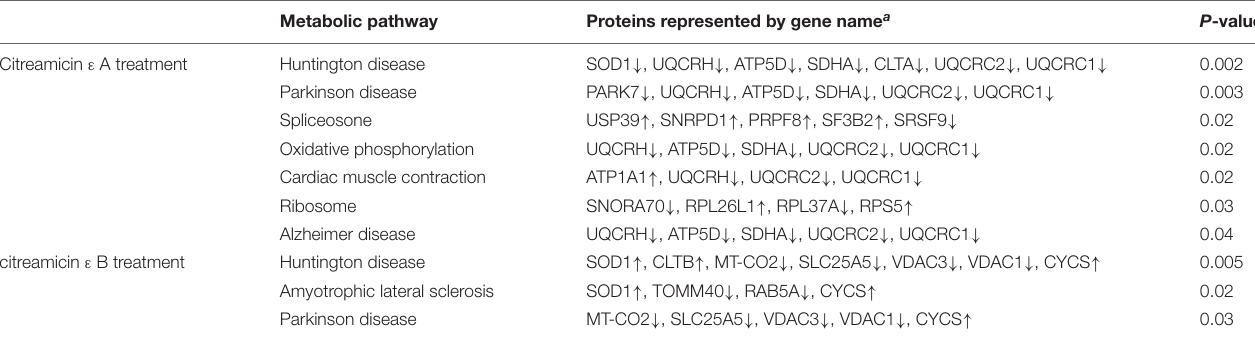
TABLE 2 | Significantly influenced pathways according to KEGG analysis in citreamicin ε A and B